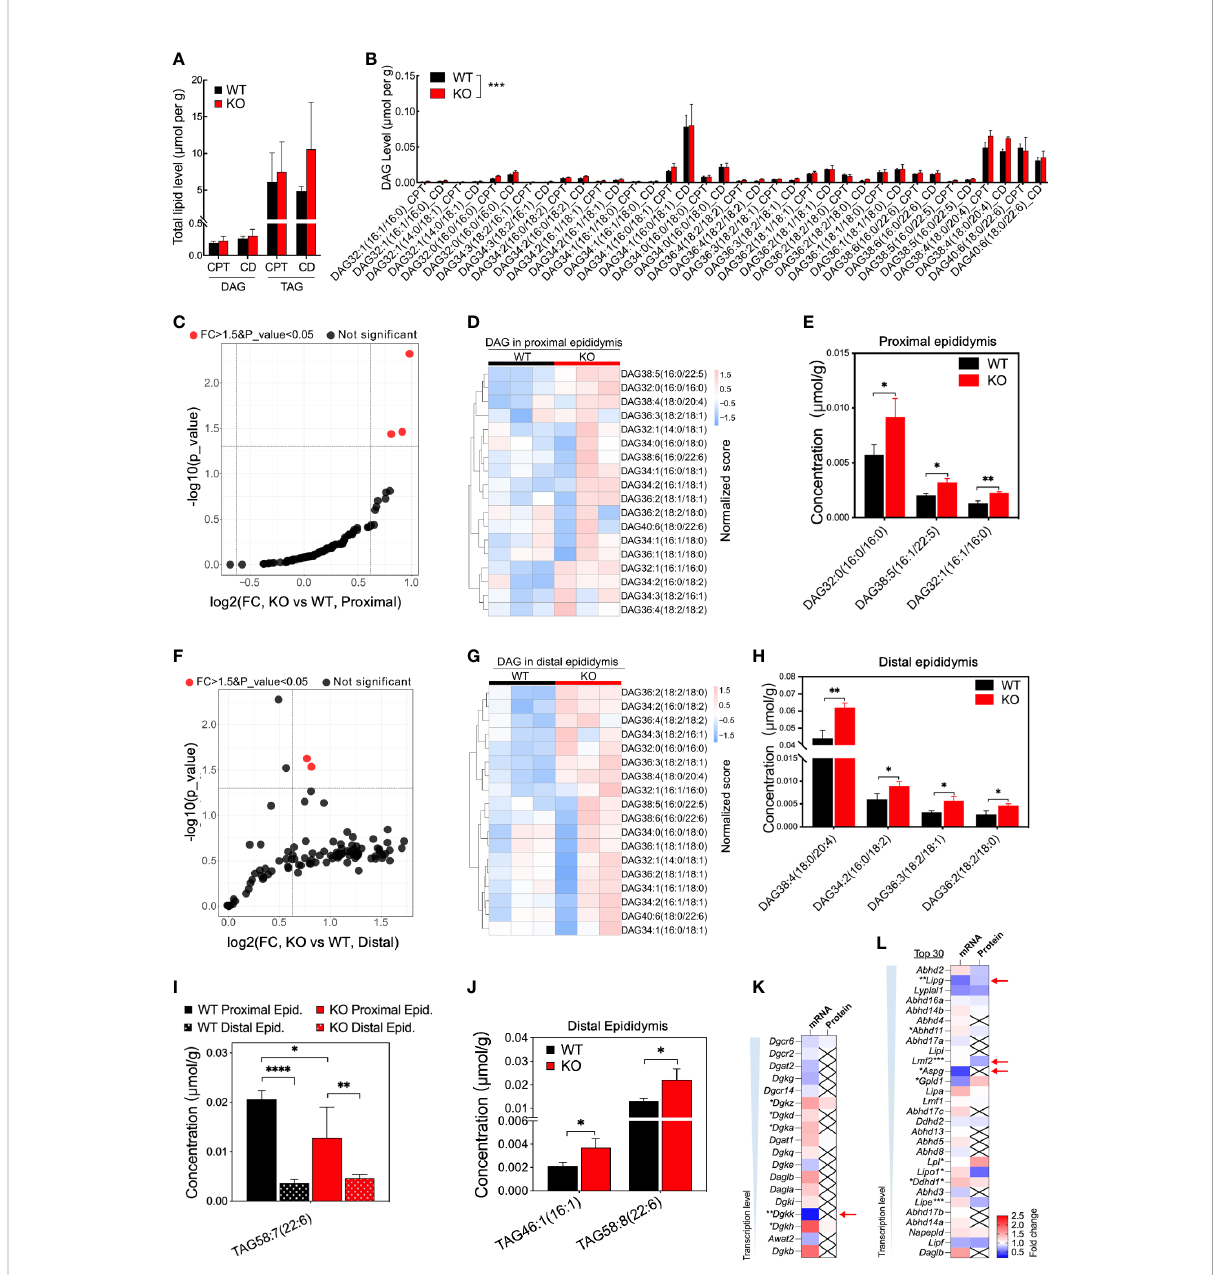
FIGURE 6 Increased concentrations of speci fi c DAG components and downregulated transcription of enzymes in Ocln- KO epididymis. (A) No difference in the total contents of DAG and TAG compositions detected in the proximal and distal epididymis of WT and Ocln- KO mice. (B) Higher levels of speci fi c DAG components in the proximal and distal epididymis of Ocln- KO mice compared to WT mice. (C) Volcano plot of DAG components in the proximal epididymis of Ocln- KO compared to WT mice. Red dots represent components with FC greater than 1.5 and signi fi cant differences at a P-value less than 0.5. Black dots represent no difference components. (D) Heatmap showing the content variation of DAG compositions in the proximal epididymis of Ocln- KO and WT mice. (E) Speci fi c DAGs at higher contents in the proximal epididymis of Ocln- KO versus WT mice. (F) Volcano plot of DAG components in the distal epididymis of Ocln- KO and WT mice. (G) Heatmap showing the content variation of DAG compositions in the distal epididymis of Ocln- KO compared to WT mice. (H) Speci fi c DAGs at higher contents in the distal epididymis of Ocln- KO versus WT mice. (I) Patterns of the speci fi c TAG components showing signi fi cantly different levels in the Ocln- KO versus WT epididymis. (J) Signi fi cantly increased TAG components in the distal epididymis of Ocln- KO versus WT mice. (K) Heatmaps of the DEGs relating to DAG converting enzymes, including DAG kinases (K) and lipases (L) in the transcriptomes and proteomes of whole mouse epididymis. Data were means ± SD, two-way ANOVA in A, B and I, two-tailed unpair t-test in F, J-L; * P< 0.05 and ** P< 0.01, *** P< 0.001, **** P < 0.0001 (n>3 experiments per